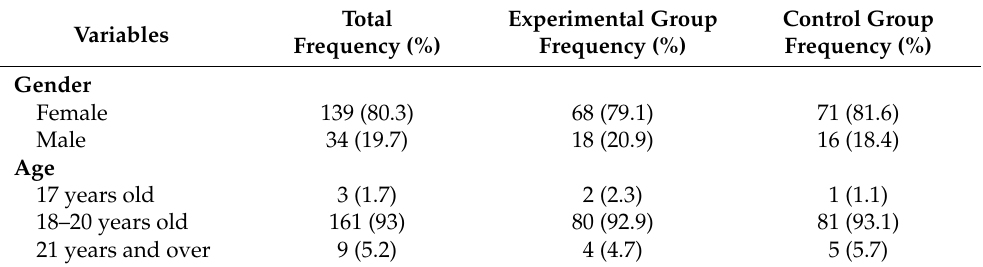
Figure 2. Flow diagram of the recruitment process. Table 1. Demographic characteristics of participants according to gender, academic background, and age (N = 173).